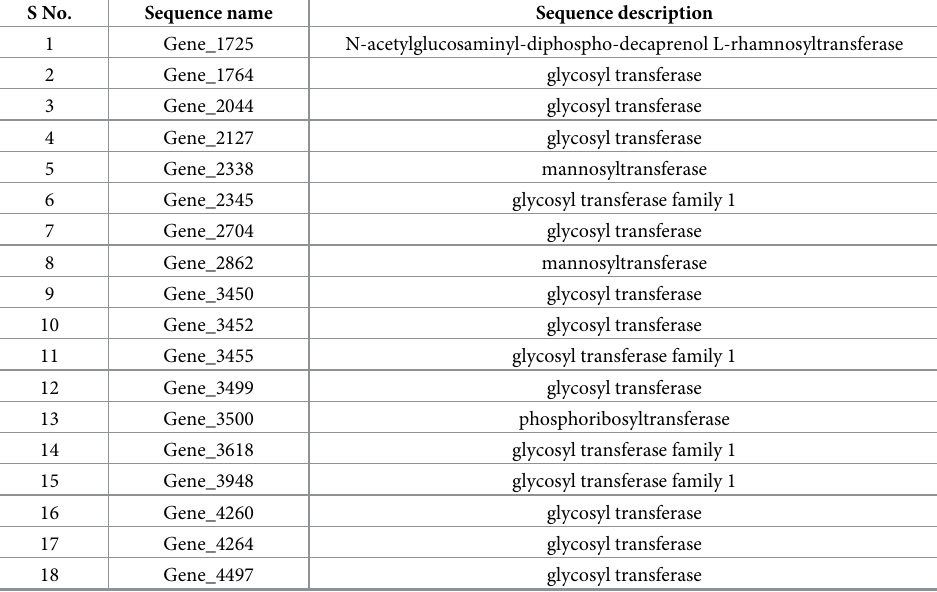
Table 4. Genes involved in linking lipid chain to carbohydrate moiety to form